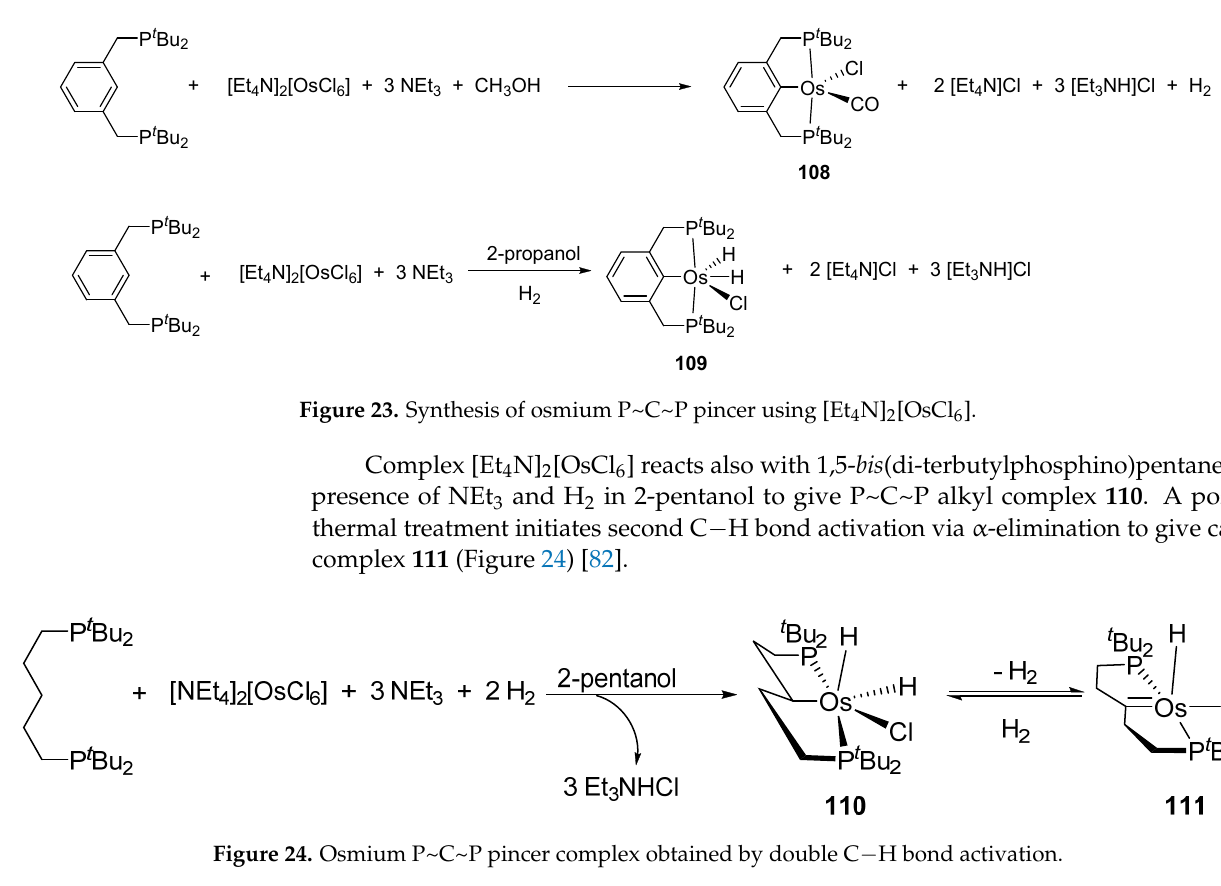
4 N] 2 [OsCl 6 ] reacts with 1,3-